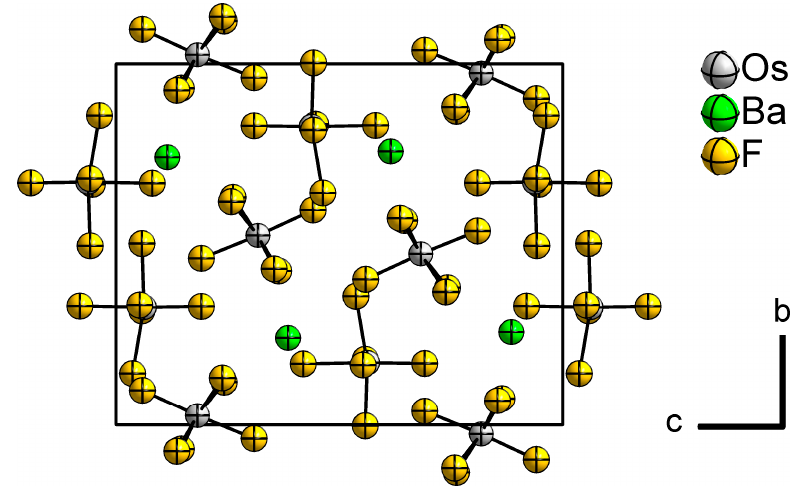
Figure 2. The crystal structure of Ba(OsF 6 ) 2 (projection along a -axis). Atoms are shown with isotropic displacement parameters, F atoms with fixed ones.